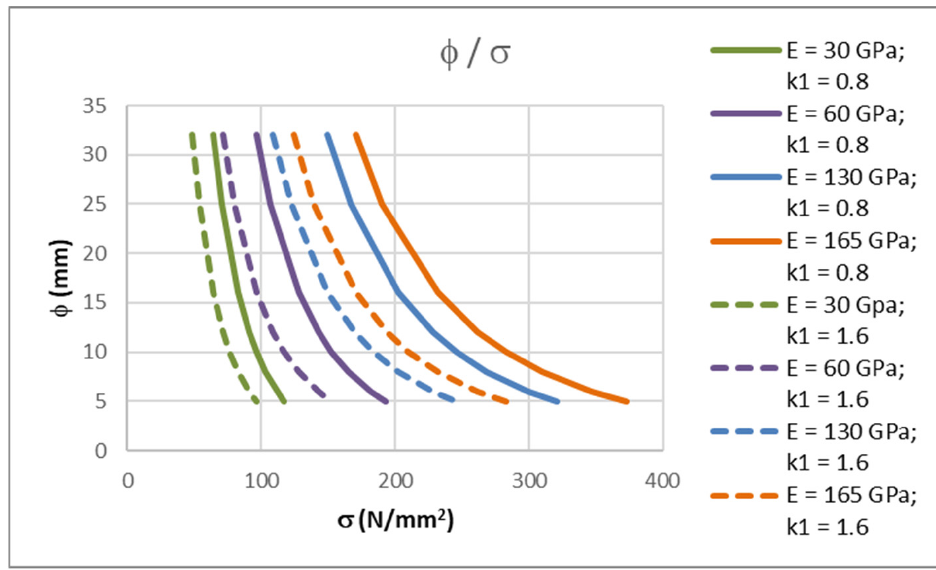
Figure 3. Comparison of maximum allowable bar diameter to stress in bar ratios for different FRP modulus of elasticity values and for k 1 = 0.8 and k 1 = 1.6.